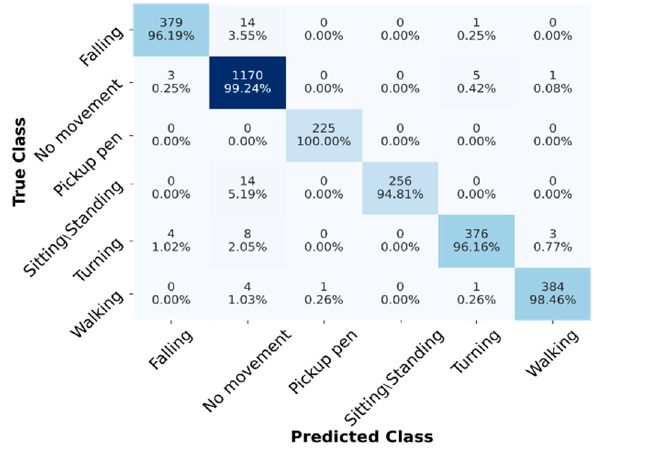
activities, i.e., Falling, No movement, Pickup pen, Sitting/Standing and Walking, show recognition accuracy greater than or equal to 92%, while only the Turning activity shows about 91.77% accuracy in the E2 scenario. There is some misclassification between the